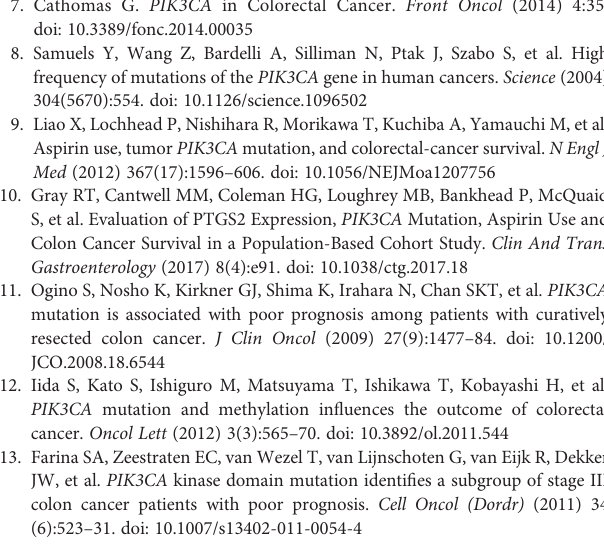
Supplementary Figure 1 | The tendency of PIK3CA mutation rates from 2014 to 2018. (A) The mutation rate of PIK3CA exon 9 in CRC patients is rising, and the estimated value of 2019 is 9.6%. (B) The mutation rate of PIK3CA exon 20 in CRC patients is slightly increased, and the estimated value in 2019 is 4.7%. (C) The mutation ratesof PIK3CA inCRC patientsareincreasing,and theestimatedvalueof 2019 is 14.2%. Supplementary Figure 2 | The detection limit of PIK3CA exon 9 mutations by the HRM test. The percentage of mutant-type spiked plasmid range from 50% to 0%, and in the 5% test, it still showed a clear bimodal image. Supplementary Figure 3 | The detection limit of PIK3CA exon 20 mutations by the HRM test. The percentage of mutant-type spiked plasmid range from 50% to 0%, and in the 5% test, it showed a clear bimodal